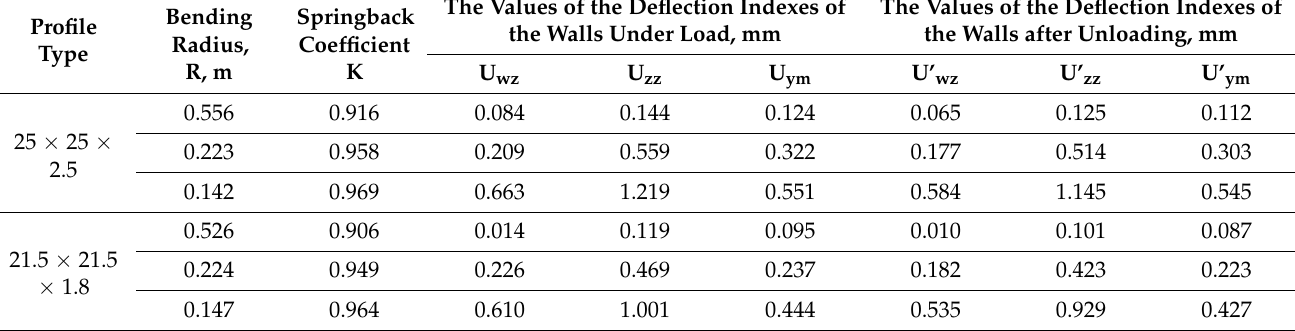
Table 1. Dependence of the springback coefficient value and wall deflection indices value on the bending radius of the 25 × 25 × 2.5 and 21.5 × 21.5 × 1.8 profile, before and after unloading.